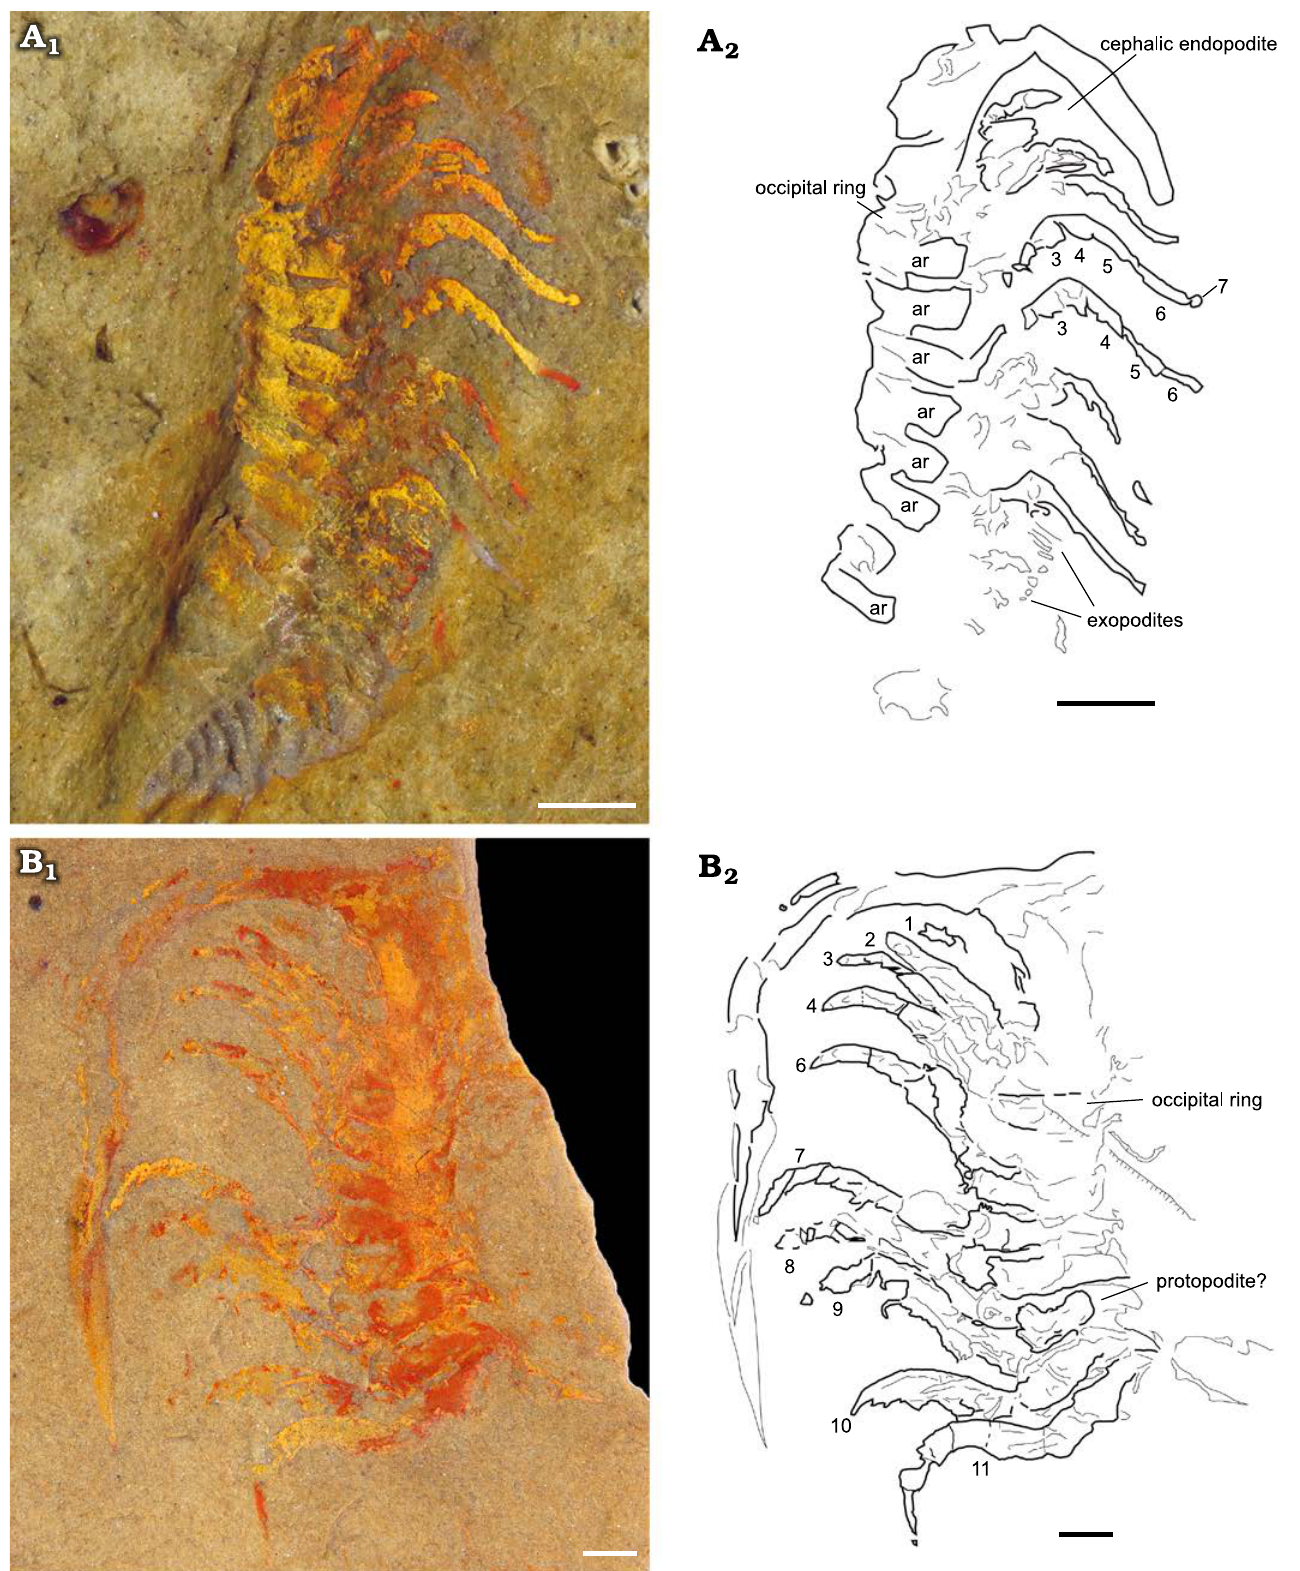
Fig. 4. Endopodites of the cheirurid trilobite Anacheirurus adserai (Vela and Corbacho, 2007) from the Fezouata Shale, Araneograptus murrayi Zone, Tremadocian, Lower Ordovician, near Beni Zouli, Zagora Province, Morocco. A . MGL 103863, photograph under alcohol with polarized light (A 1 ), explanatory drawing with podomere numbers (A 2 ). B . MGL 102225, photograph under alcohol with polarized light (B 1 ), explanatory drawing with endo- podite numbers (B 2 ). Scale bars 1 mm. Abbreviations: ar, axial